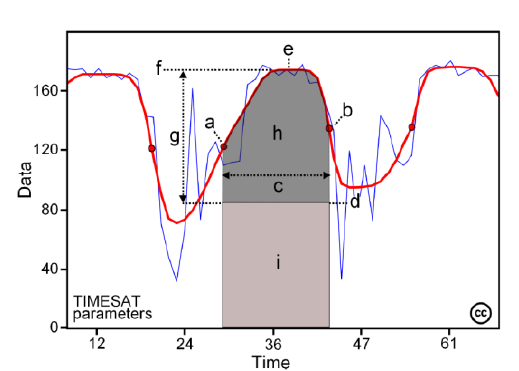
Figure 2. Examples of seasonality parameters generated by TIMESAT: (a) beginning of season, (b) end of season, (c) length of season, (d) base value, (e) time of middle of season, (f) maximum value, (g) amplitude, (h) small integrated value, (h+i) large integrated value. The red line represents the filtered data, and blue the original